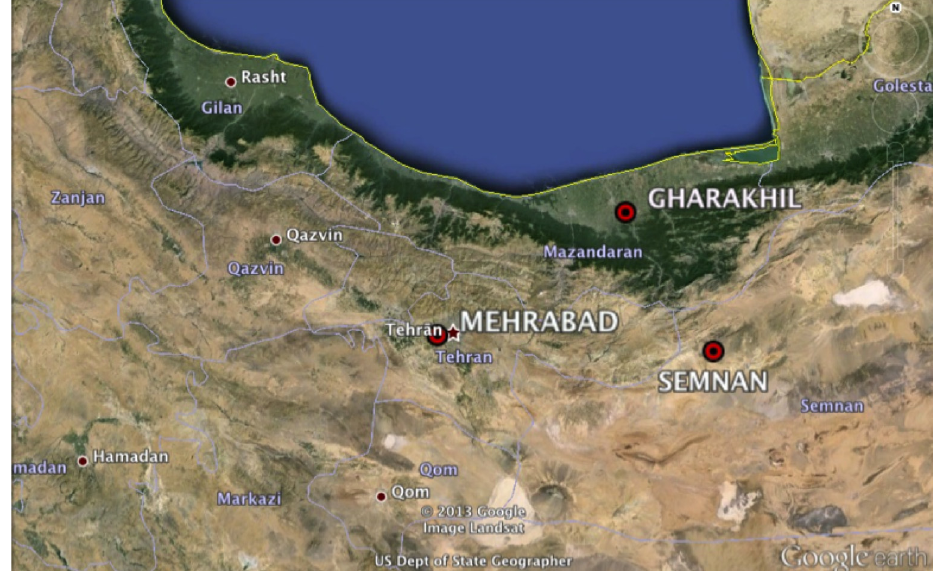
Figure 1. Geographic locations of the ground-based meteorological monitoring